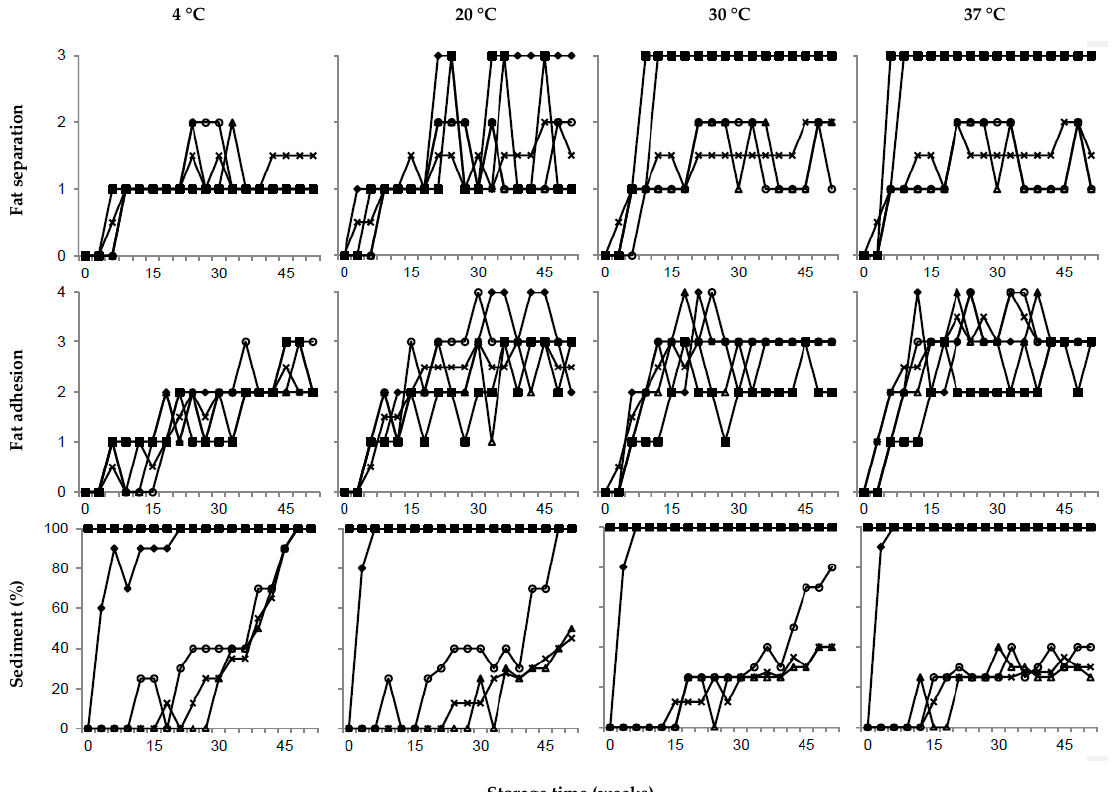
Figure 2 . Variation in sediment formation, fat separation, and fat adhesion in ultra-high temperature treated milk for selected samples with elevated levels of ( ■ ) calcium, ( ○ ) citrate, ( ∆ ) urea, ( ♦ ) calcium and citrate, and average values of two batches ( × ) unmodified reference ultra-high temperature treated milk during storage from 0–52 weeks at 4, 20, 30, and 37 °C.